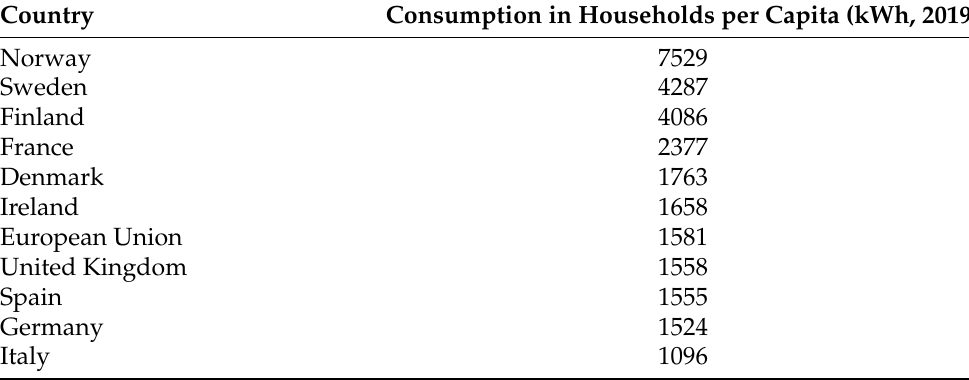
Table 8. Consumption in households of electricity per capita in Norway, EU and some other countries (kWh, 2019). Source: Eurostat.